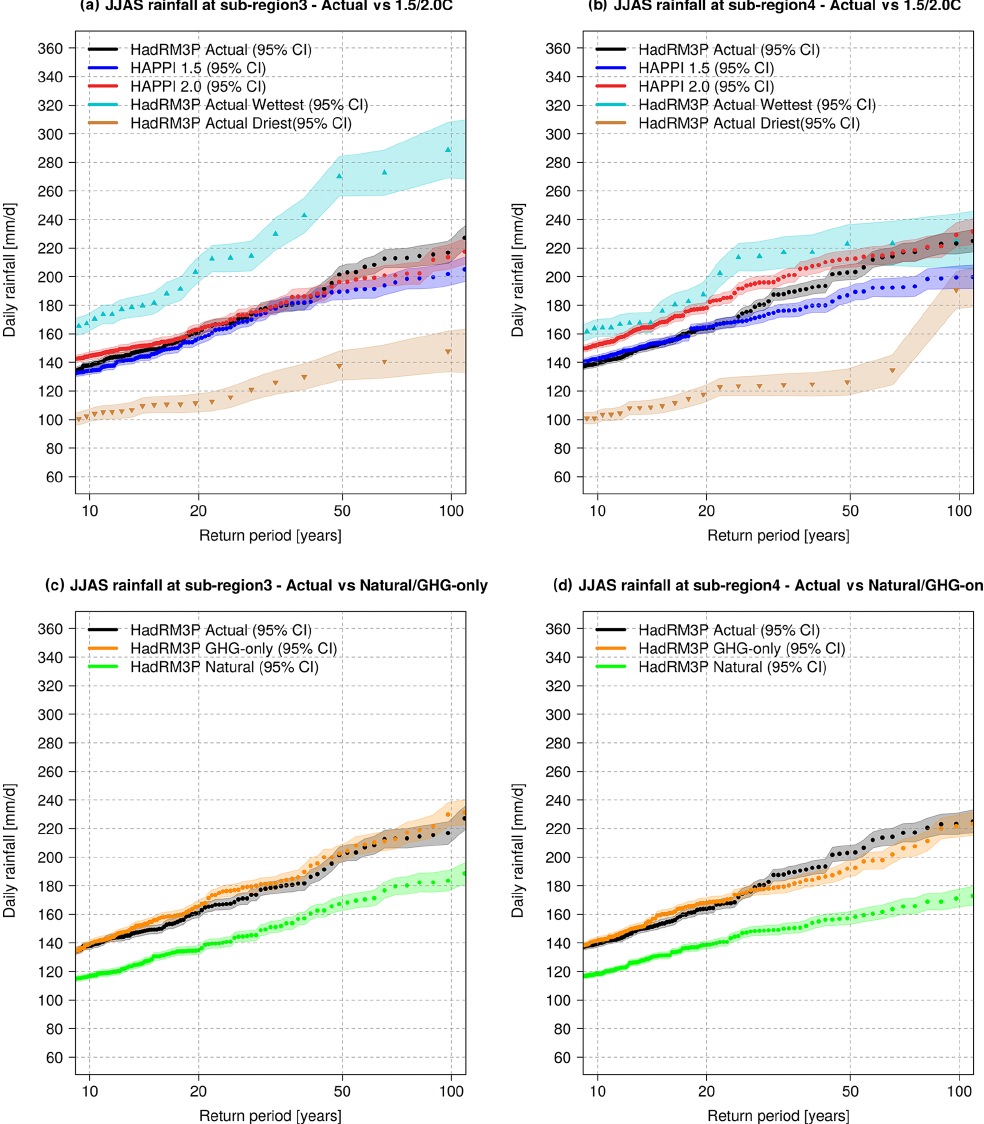
Figure 9. Same as Fig. 8, but showing return time plots for daily rainfall during monsoon (JJAS) season in different forcing scenarios over the sub-regions of 3 and 4 of